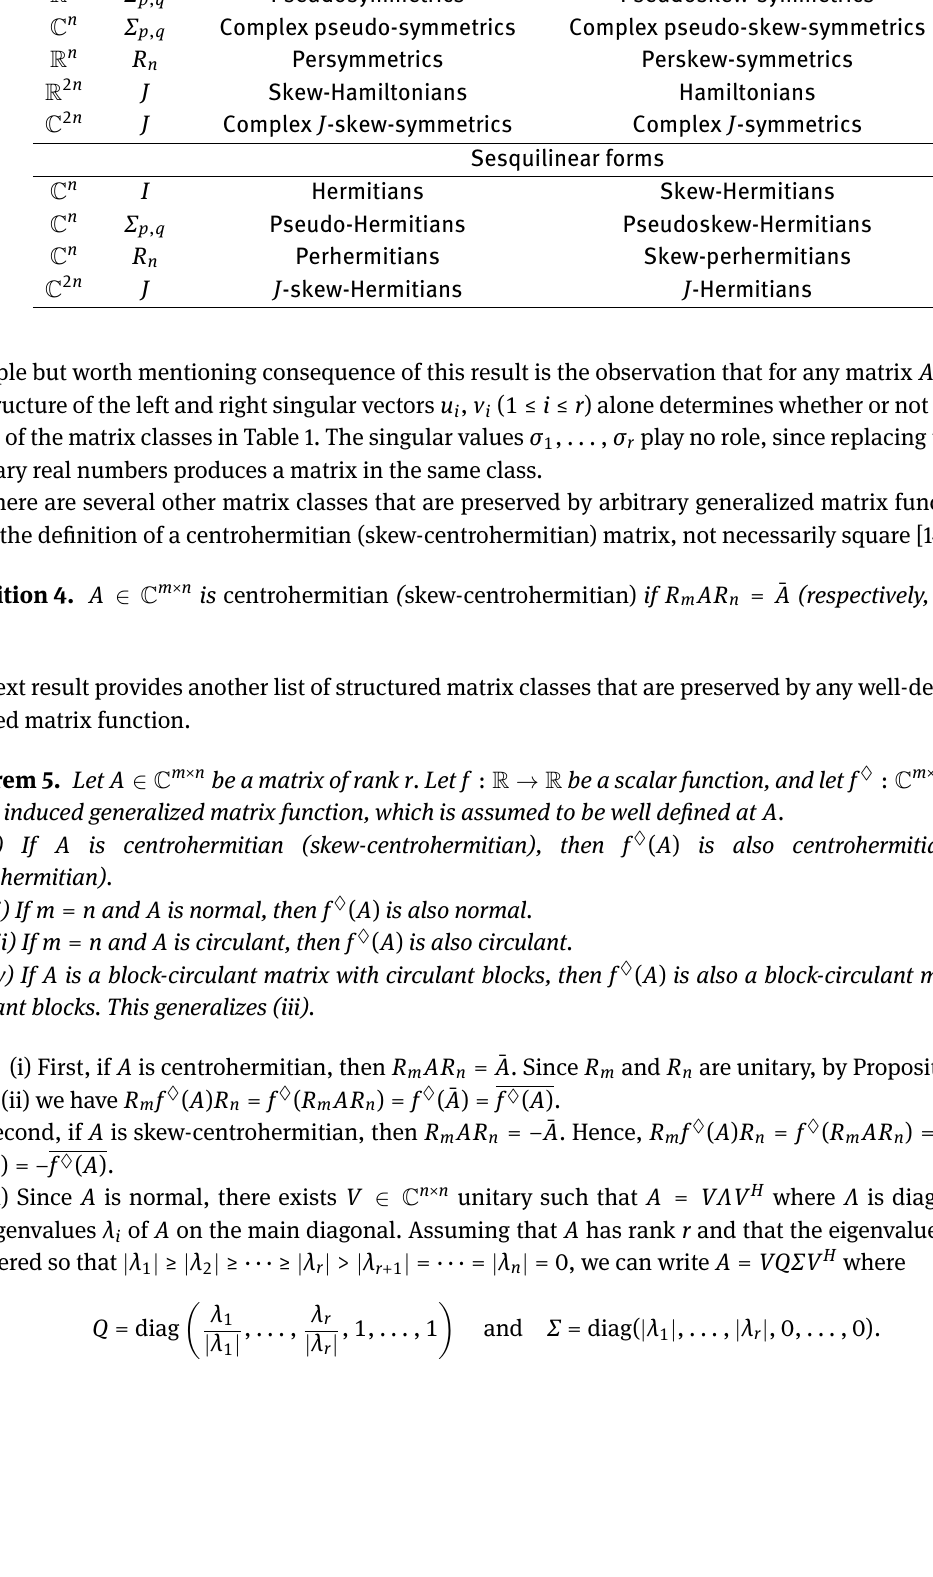
Table 1: Structured matrices associated with certain bilinear and sesquilinear forms Space M Jordan Algebra J = (cid:8) A : A * = A (cid:9) Lie Algebra L = (cid:8) A : A * = − A (cid:9) Bilinear forms R n I Symmetrics Skew-symmetrics C n I Complex symmetrics Complex skew-symmetrics R n Σ p , q Pseudosymmetrics Pseudoskew-symmetrics C n Σ p , q Complex pseudo-symmetrics Complex pseudo-skew-symmetrics R n R n Persymmetrics Perskew-symmetrics R 2 n J Skew-Hamiltonians Hamiltonians C 2 n J Complex J -skew-symmetrics Complex J -symmetrics Sesquilinear forms C n I Hermitians Skew-Hermitians C n Σ p , q Pseudo-Hermitians Pseudoskew-Hermitians C n R n Perhermitians Skew-perhermitians C 2 n J J -skew-Hermitians J